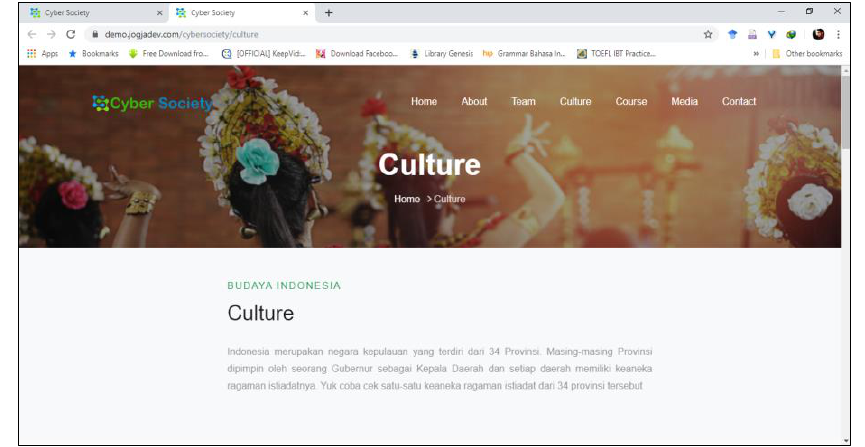
Fig. 6. Menu of Culture to show information of regions in Indonesia